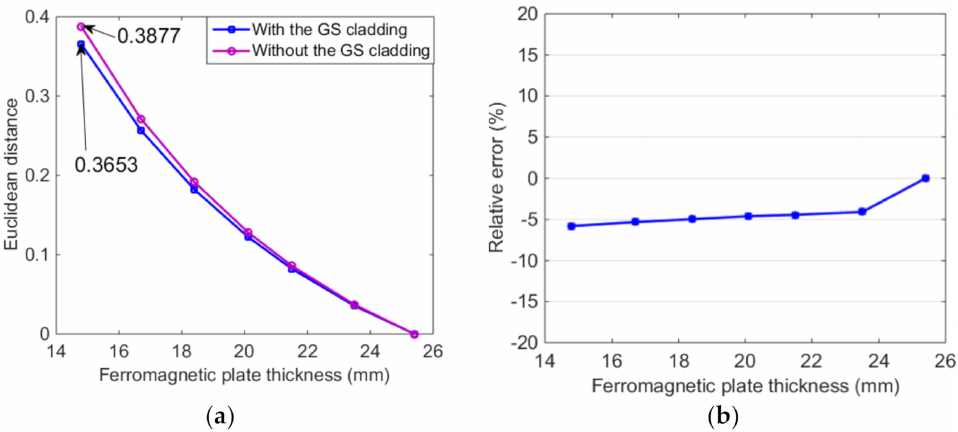
Figure 6. ( a ) Euclidean distances obtained with and without the GS cladding. ( b ) associated rela- tive